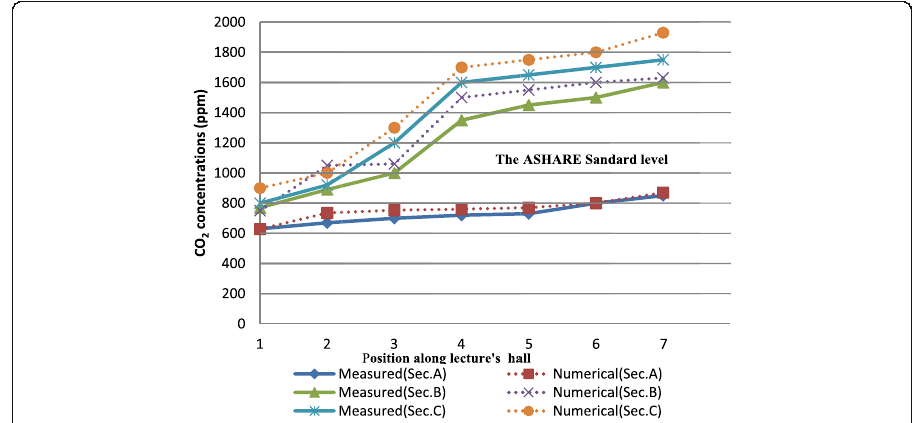
Fig. 6 Comparison of the measured and simulated CO 2 values (ppm) (source: the authors)